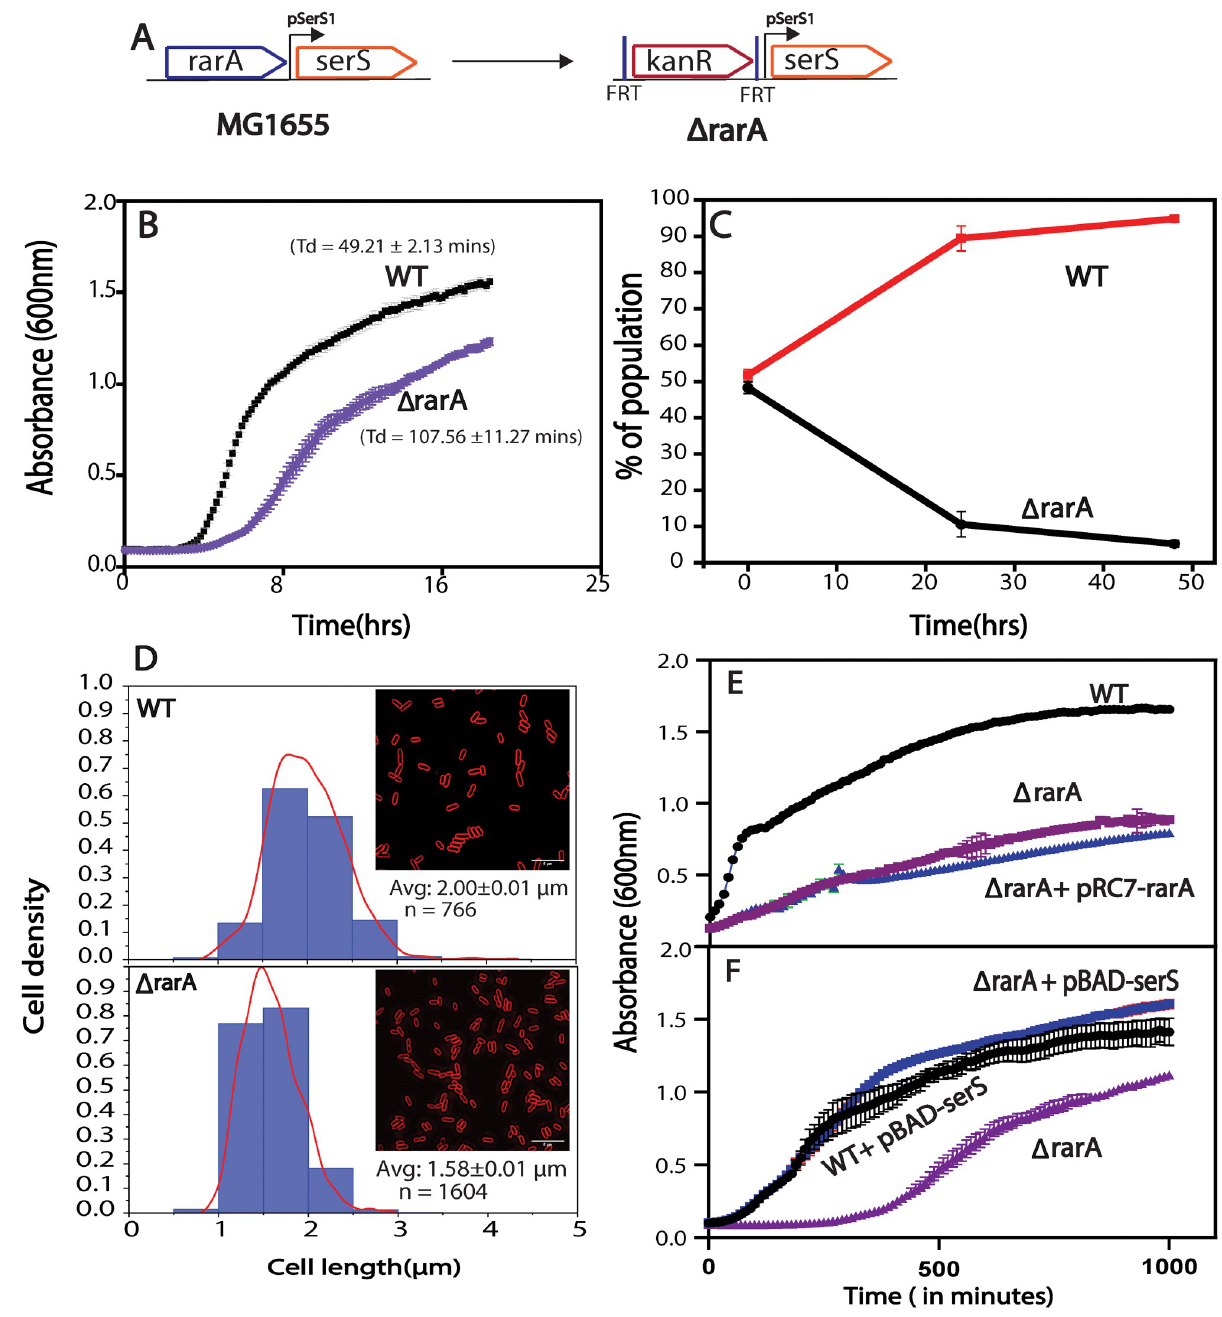
Fig 2. Complete deletion of rarA ( Δ rarA) causes a growth defect in E . coli cell. (A) Schematic of a complete deletion of rarA via a FLP recombinase method in E . coli chromosome. The rarA gene segment is replaced by a Kan cassette. (B) Growth curve: Deletion of complete rarA gene exhibit growth defect. (C) Growth competition: Δ rarA is outcompeted by WT cells (D) Average cell size of Δ rarA cells decreases compared to WT cells. (E) Addition of pRC7- rarA , carrying WT rarA copy, in Δ rarA cell does not rescue its growth defect. (F) Overexpression of serS using pBAD vector rescues the growth defect of Δ rarA cells (blue line). Error bars on the graph and in reported doubling times represent the standard deviation of at least three independent repeats carried out on the same day in the same microtiter plate. Each experiment was also repeated on three different days (each time in triplicate) with consistent results to confirm the